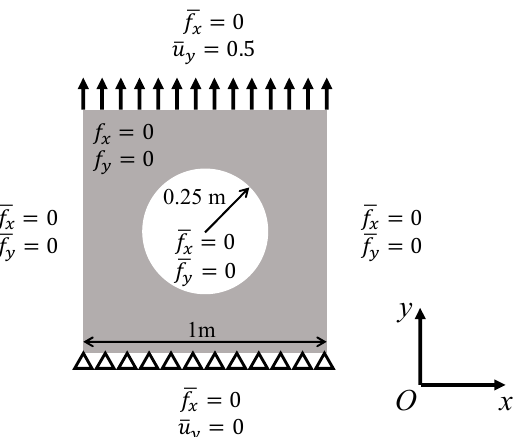
Figure 2. Diagram of an open-holed square plate under a uniaxial load.